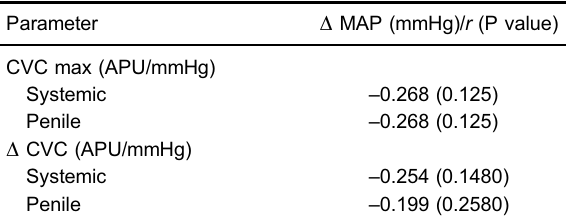
Table 3. Correlations between mean arterial pressure changes induced by sildena fi l, and endothelium-dependent systemic and penile microvascular reactivity in hypertensive patients.